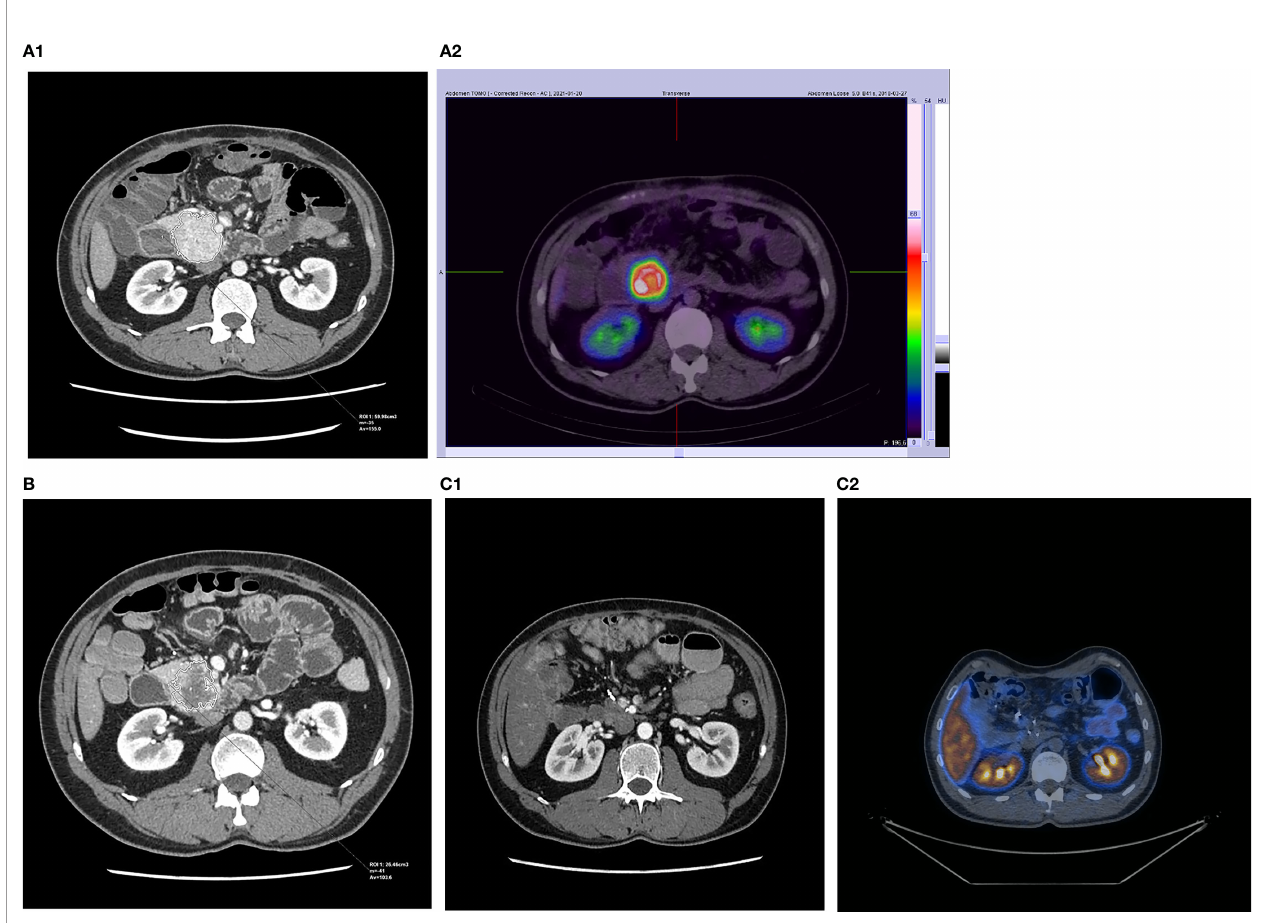
FIGURE 2 | CT and SRI scans of a patient with successfully operated NET of the pancreas: (A1, 2) before PRRT, (B) 3 months after 4 cycles of 177Lu/90Y-DOTA- TATE (only CT), and (C1, 2) after complete tumor removal.